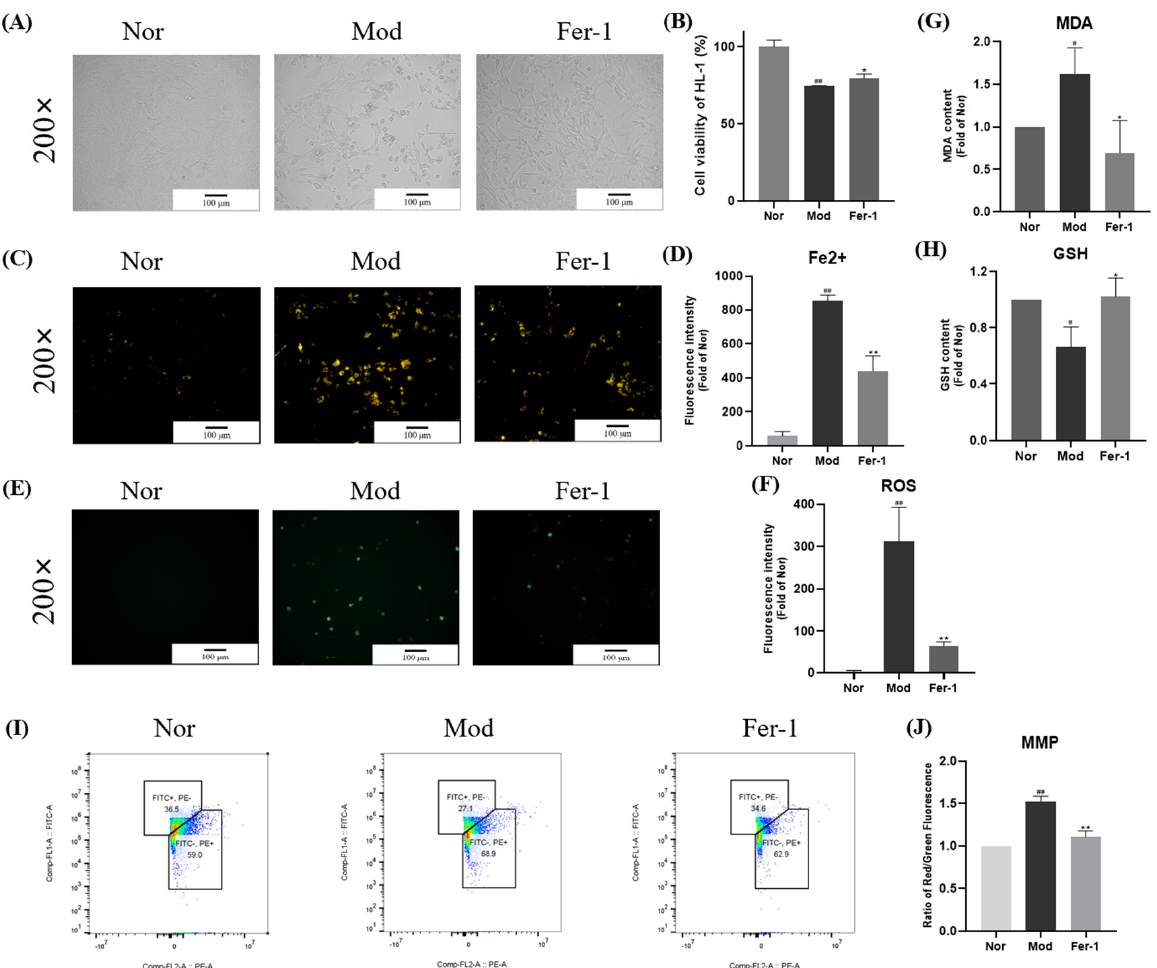
Figure 3. Ferroptosis is observed in PA-treated HL-1 cells. HL-1 cells were stimulated with 0.1 mM PA for 24 h in the presence or absence of Fer-1 (5 µ M). ( A ) Representative images of live cells. ( B ) Effects of ferroptosis inhibitor Fer-1 on cell viability of HL-1 cells, which were analyzed by MTT assay. ( C ) Representative images of intracellular Fe 2+ in HL-1 cells stained with FeRhoNox-1. ( D ) Quantification analysis of intracellular Fe 2+ . ( E ) Representative images of intracellular ROS in HL-1 cells stained with DCFH-DA. ( F ) Quantification analysis of intracellular ROS. ( G ) Intracellular MDA was assessed by MDA kit. ( H ) Intracellular GSH was assessed by GSH kit. ( I , J ) Quantification analysis of mitochondrial membrane potential in HL-1 cells by flow cytometry. Nor, normal control group; Mod, untreated PA control group; Fer-1, Fer-1-treated PA group. Data were expressed as mean ± SD ( n = 3). Differences were considered significant at p < 0.05 and highly significant at p < 0.01 (# p < 0.05, ## p < 0.01 vs. Nor; * p < 0.05, ** p < 0.01 vs. Mod).